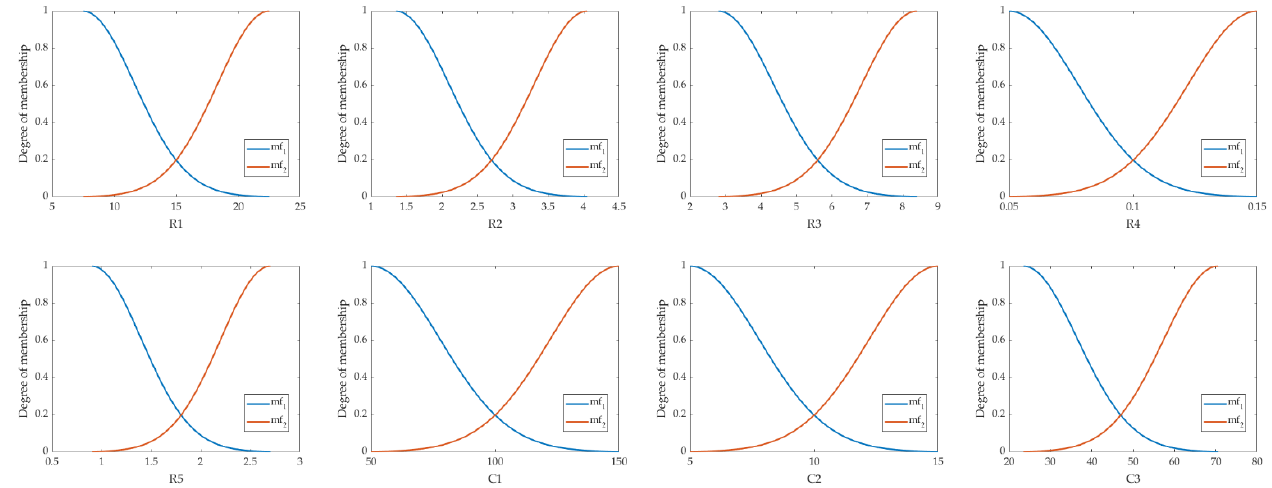
Figure 7. Membership functions employed for Av and for THD before tuning the Fuzzy Inference Systems.